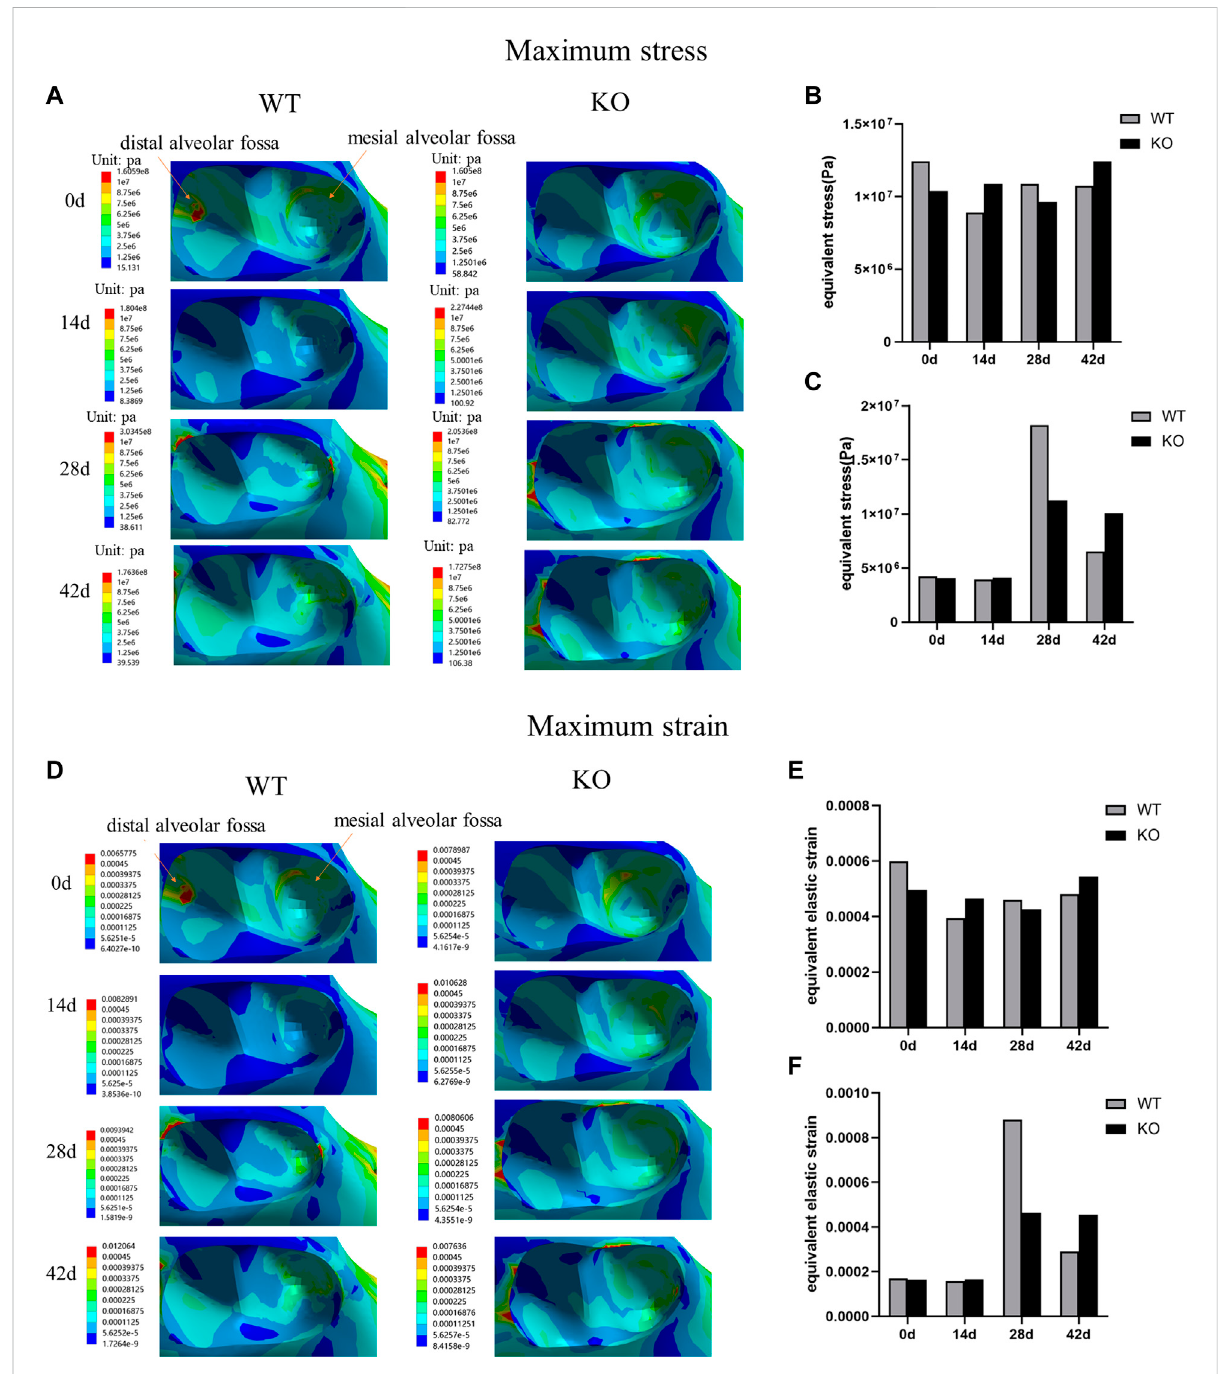
FIGURE 6 (A) Maximum stress of the alveolar bone of the left mandibular fi rst molar in WT and KO mice under the buccal loading of 5 N · m. (B) Maximum stress of alveolar bone at tooth root. (C) Maximum stress of alveolar bone at tooth cervix. (D) Maximum strain of the alveolar bone of the